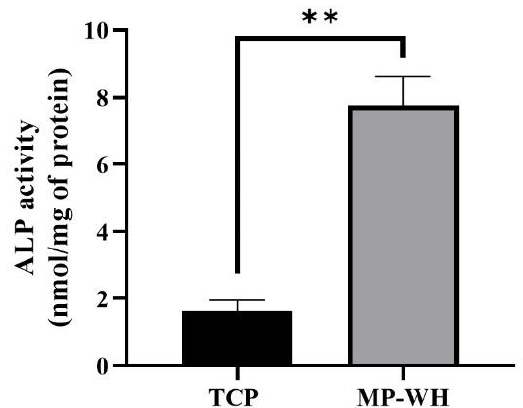
Figure 6. Alkaline phosphatase (ALP) activity of human mesenchymal stem cells (hMSCs) cultured on tricalcium phosphate (TCP) and marine plankton-derived whitlockite (MP-WH) 3D scaffold. Data represent the mean ± standard deviation (SD) for three samples. ** p < 0.01 indicates significant differences from that of the TCP 3D scaffold.